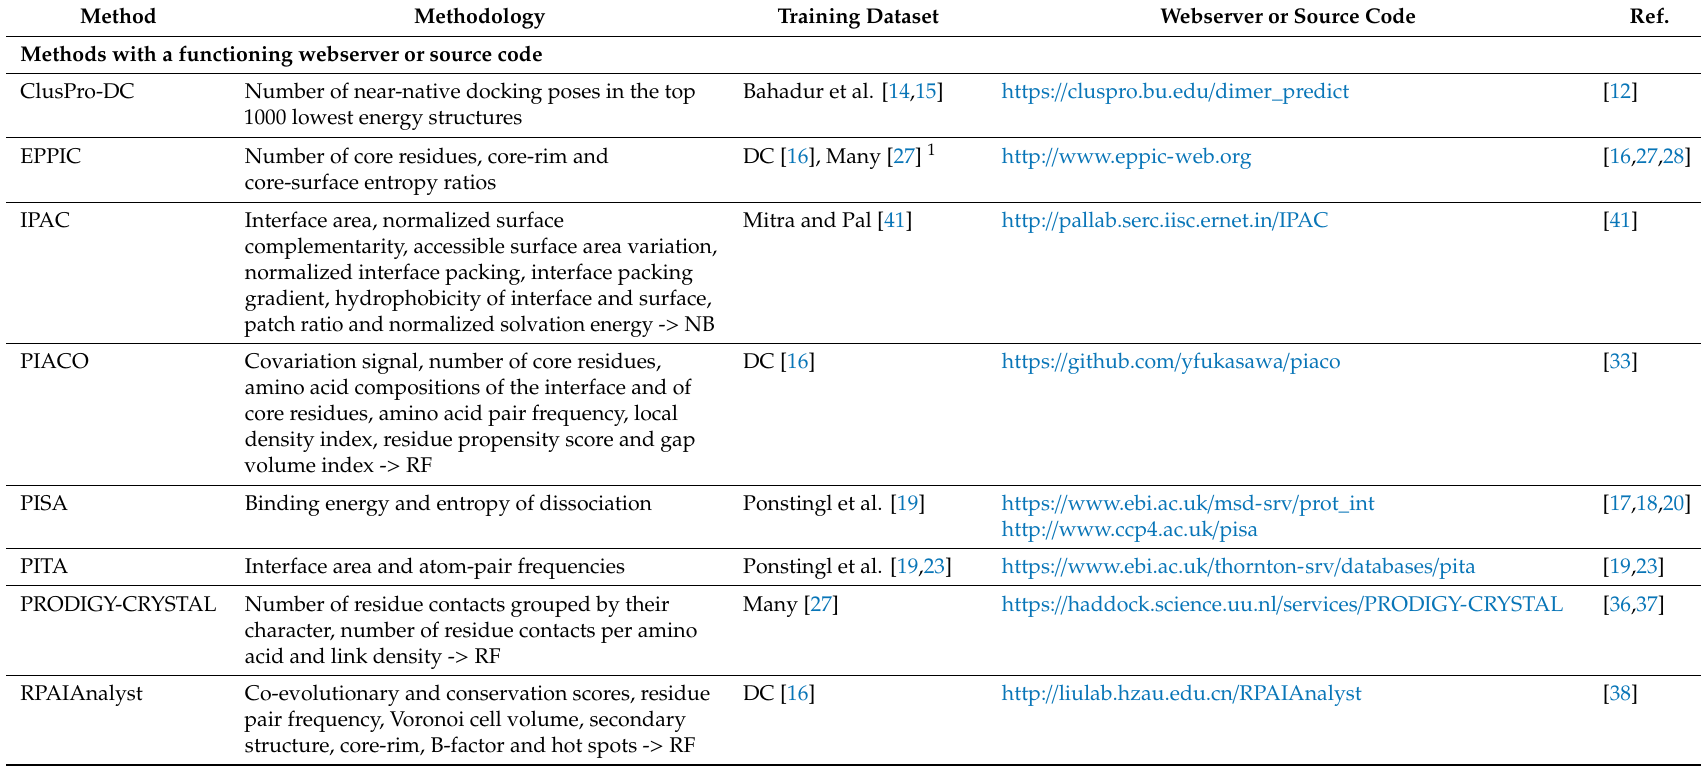
Table 1. List of biological interface